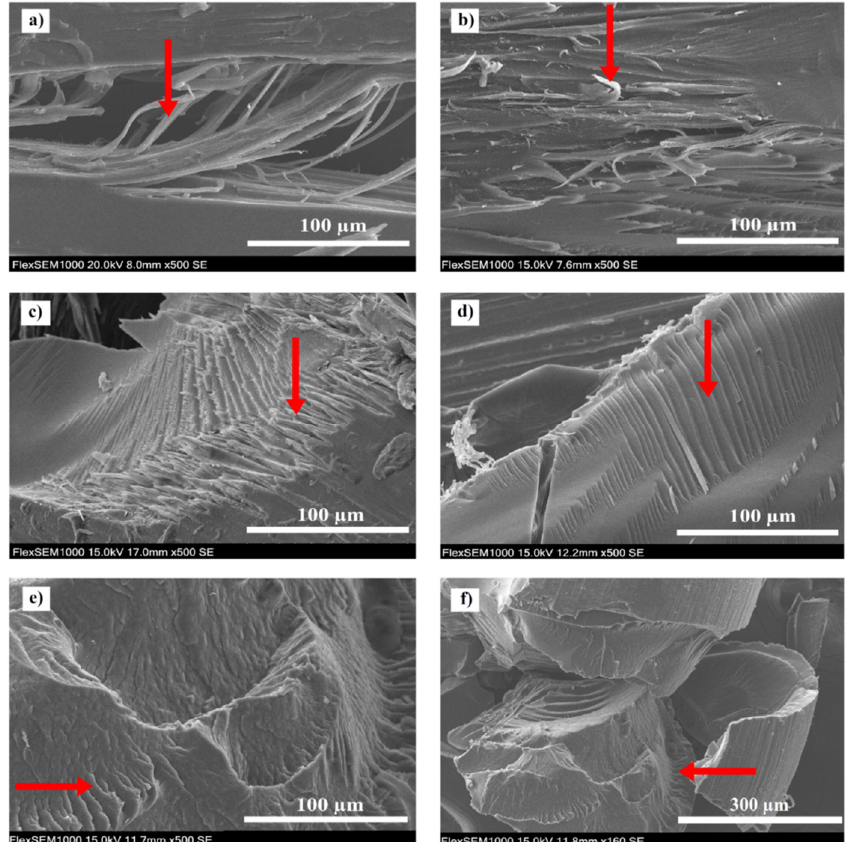
Figure 6. Fracture surfaces of the stents: ( a ) non−degraded, ( b ) 4−weeks−degraded, ( c ) 8−weeks−degraded, ( d ) 16−weeks−degraded and ( e ) and ( f ) 24−weeks−degraded stent. The arrows point at structures typical of the corresponding level of degradation.